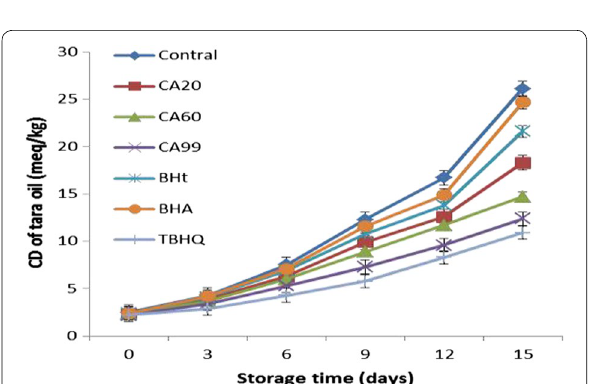
Fig. 4 CD results for tara seed oil samples after accelerated